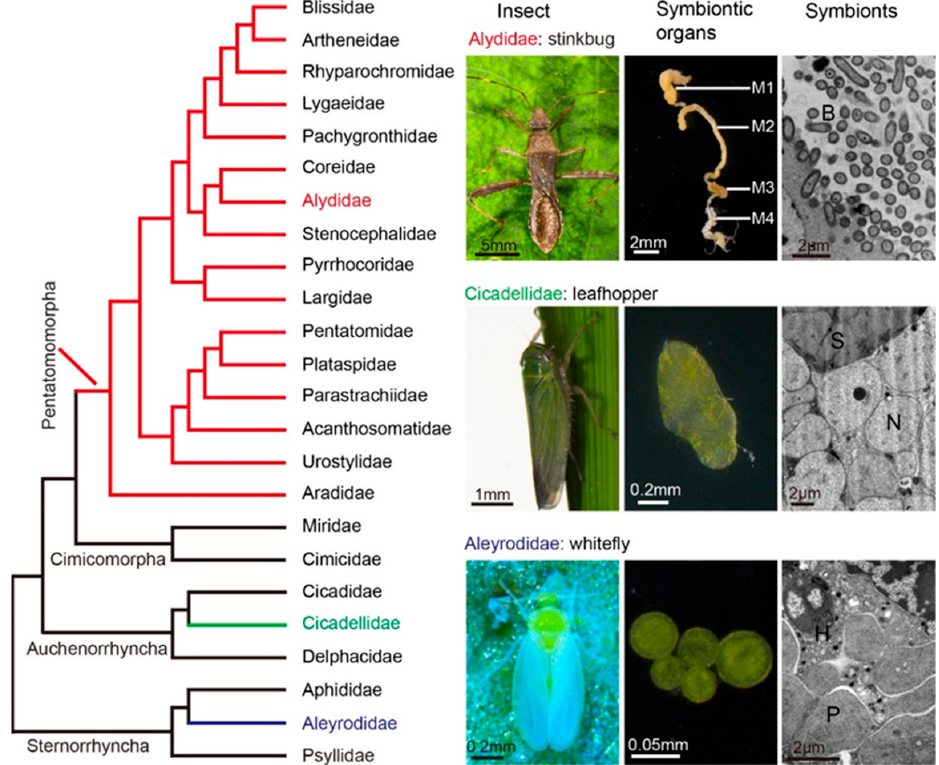
Figure 1. Phylogeny of stinkbugs in Hemiptera. Left panel: A simplified phylogeny of the pentatomomorphan stinkbugs in Hemiptera. The red colored lines indicate the families of stinkbugs. The tree is based on the references [6,18] with slight modification. Right panel: The insect hosts, their symbiotic organs and bacterial symbionts in three representative families of the suborders Heteroptera (the infraorder Pentatomomorpha), Auchenorrhyncha, and Sternorrhyncha. Top images (from left to right): an alydid stinkbug Riptortus pedestris , the four sections of the midgut, and the transmission electron micrographs (TEM) of Burkholderia symbiont in midgut crypts. M1, midgut first section; M2, midgut second section; M3, midgut third section; M4, midgut fourth section with crypts; B: Burkholderia . Middle images: a planthopper Laodelphax striatellus, bacteriome and the micrograph of their dual obligate symbionts Nasuia and Sulcia in bacteriome. N: Nasuia ; S: Sulcia . Bottom images: A whitefly Bemisia tabaci , bacteriocytes, and the micrograph of obligate symbiont Portiera and facultative symbiont Hamiltonella in bacteriocyte. P: Portiera ; H: Hamiltonella